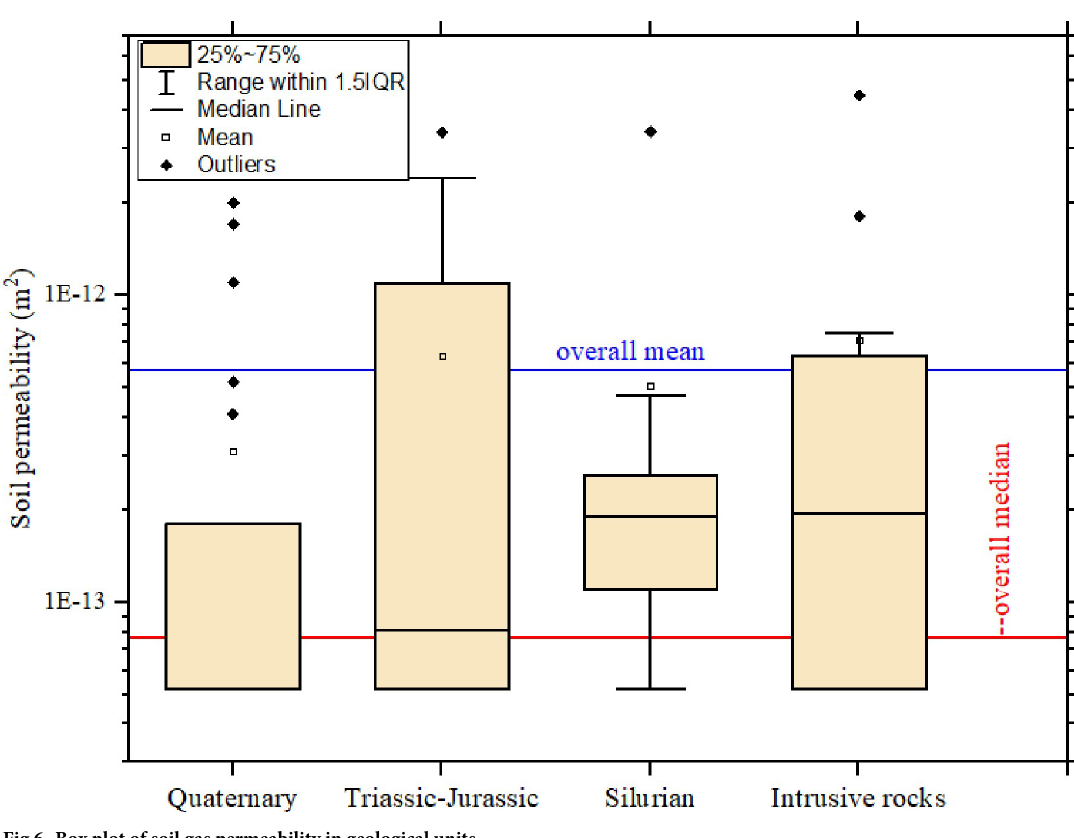
Fig 6. Box plot of soil gas permeability in geological